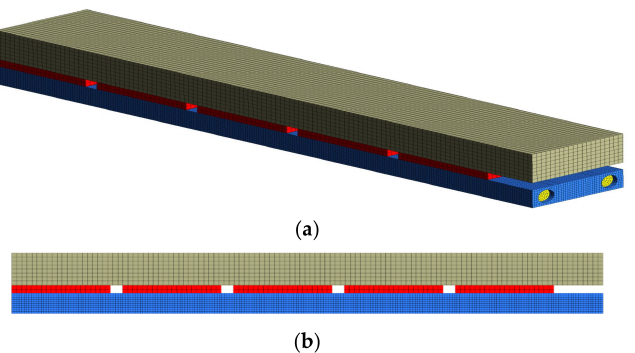
Figure 4. ( a ) Top and ( b ) side views of structural hexahedral mesh of the CFD model used in this